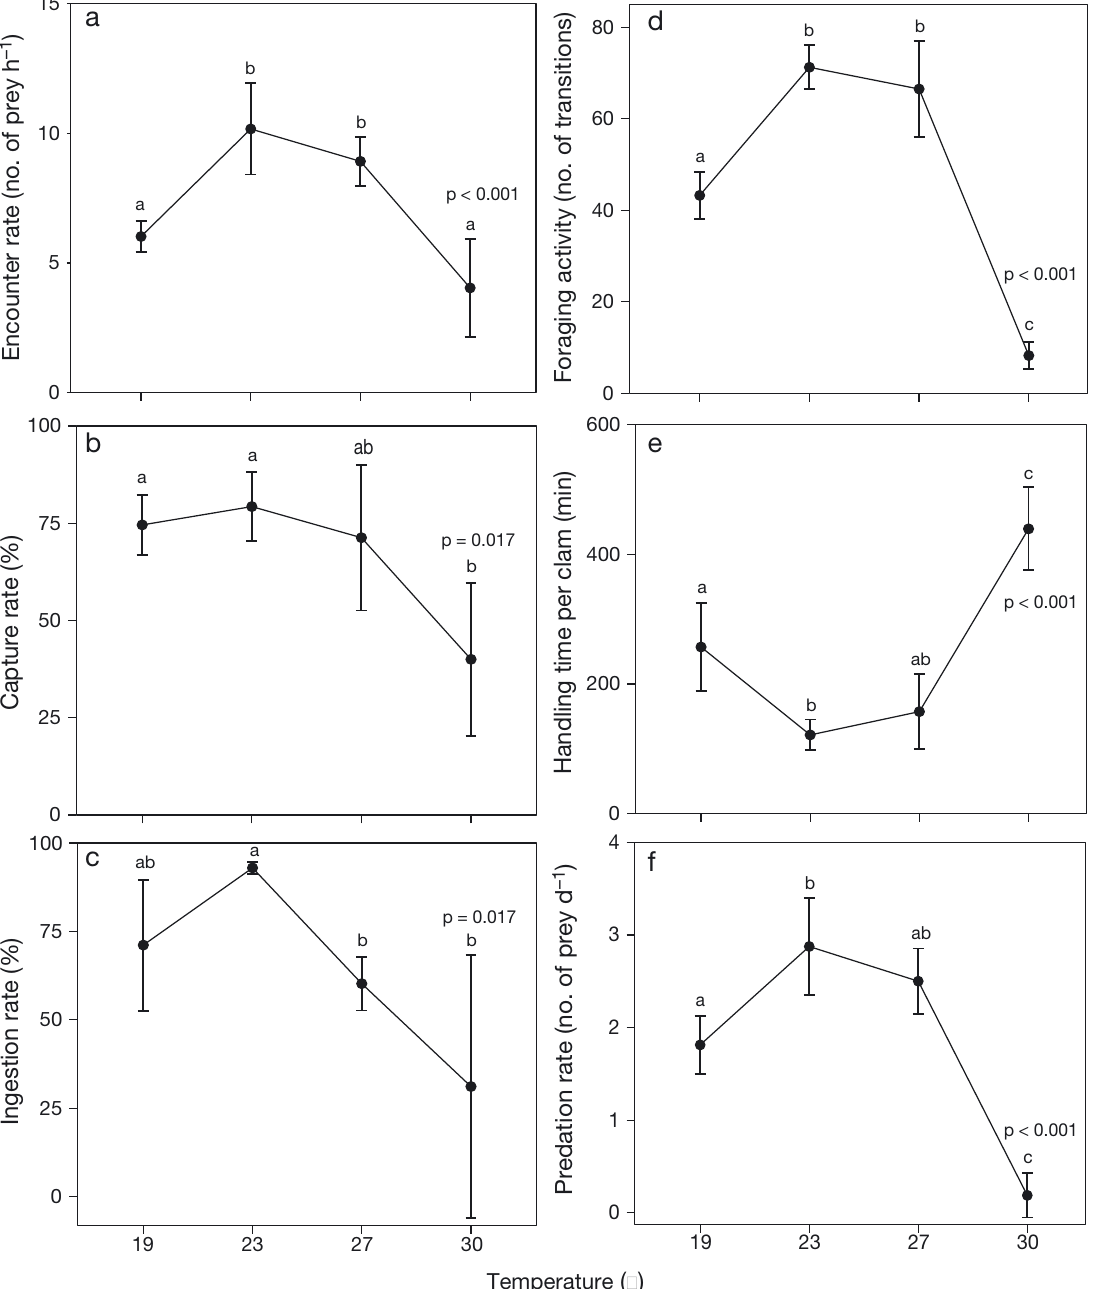
Fig. 2. Foraging performance and predation rate of adult Rapana venosa under 19, 23, 27 and 30°C: (a) encounter rate between whelks and clams, (b) capture rate upon encounter, (c) ingestion rate upon capture, (d) foraging activity, (e) handling time per clam, and (f) predation rate. All data are means ± SD, n = 4 for each temperature. Statistical significance (p < 0.05, 1-way ANOVA) is indicated by the p-value and different lowercase letters indicate significant differences between temperature